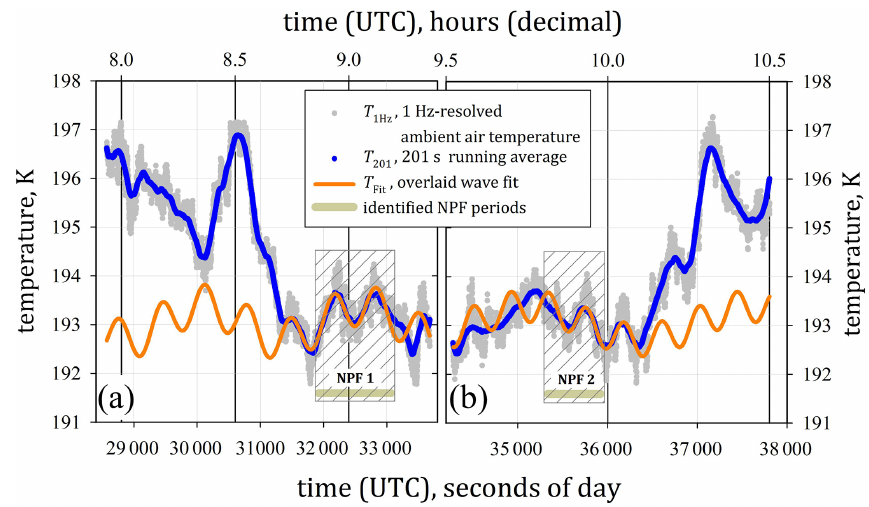
Figure 14. Close-up view of the two sections of StratoClim 2017 flight KTM 6 on 6 August 2017 over time ranges of more than 1h of flight time, respectively, including the two identified NPF periods (horizontal bar in panels a and b ). For analysing the observed temperature anomaly, the 1Hz resolved temperature data are filtered by the noise-reducing running average over 201 data points ( T 201 ). The wave fit ( T Fit ) is approximated to the noise-filtered data set within the period of identified NPF (see Appendix B for details). The overlaid fit function approximates the characteristic structure of the observed temperature anomaly only within the two NPF